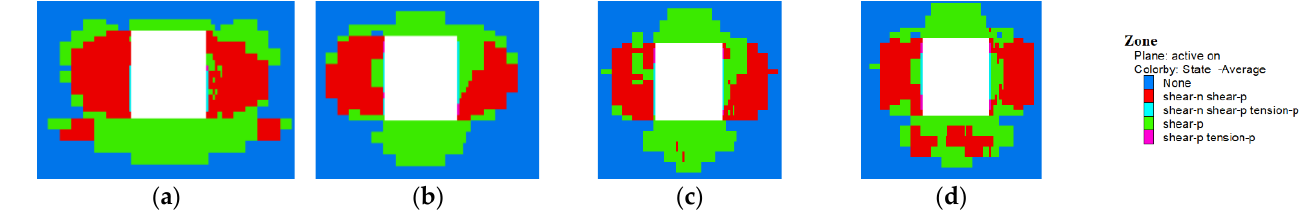
Figure 5. A cloud diagram of the plastic zone of the cavern with different lateral pressure coeffi- cients. ( a ) γ = 0.5; ( b ) γ = 1.0; ( c ) γ = 1.5; and ( d ) γ =